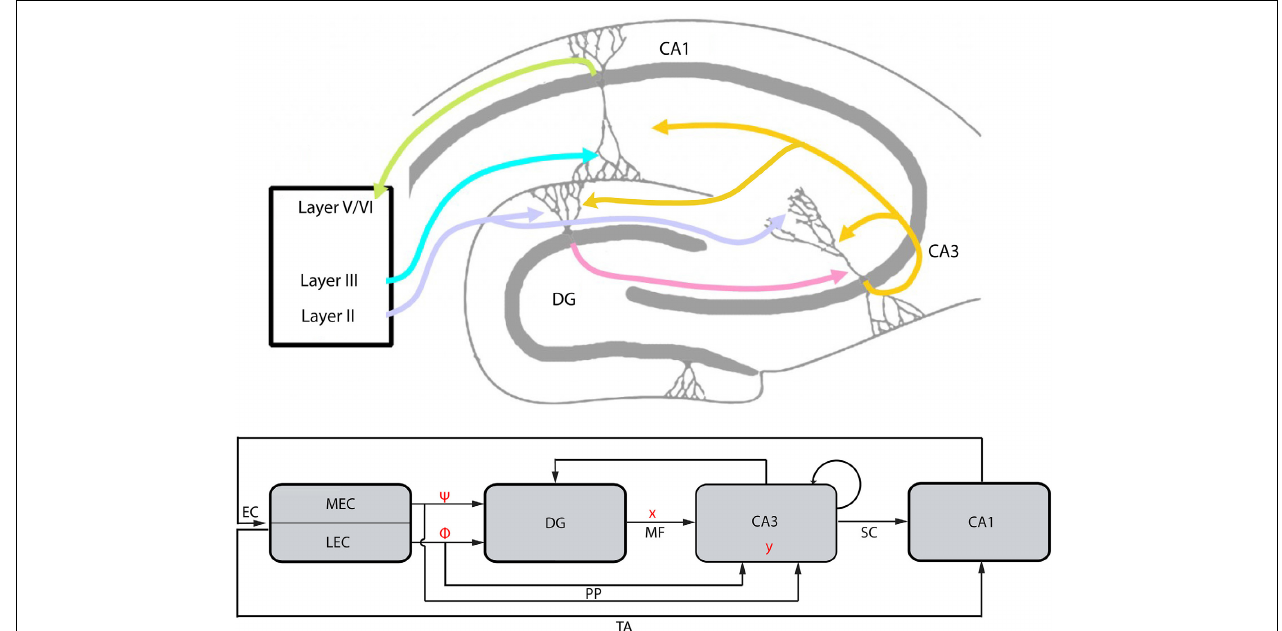
FIGURE 4 | The EC-DG-CA3-CA1 circuit and the conceptual parallelism with the CS framework (top: hippocampal structure; bottom: abstract graphical representation of hippocampal structure and conceptual parallelism with CS framework). The EC projection to DG and CA3, via the perforant path (PP), represents the matrix A of the CS framework. It is analyzed to matrices (cid:2) and (cid:3) that are linked with subregions LEC and MEC, respectively. Vector x corresponds to the activity of DG afferents projecting